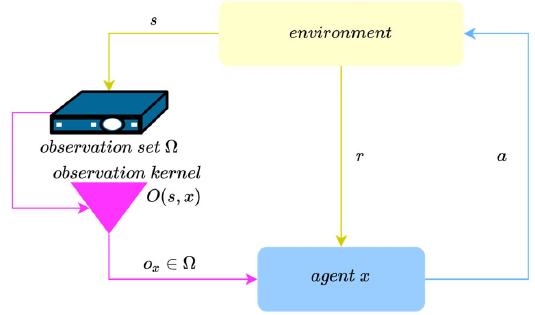
Figure 3. The POMDP framework.